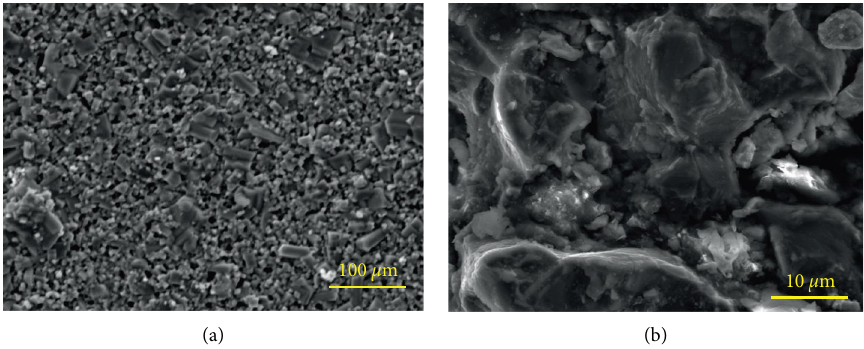
Figure 9: Tempered Al-Si/63%SiCtest specimen (a) Matrix failure (b) debonding between the matrix and